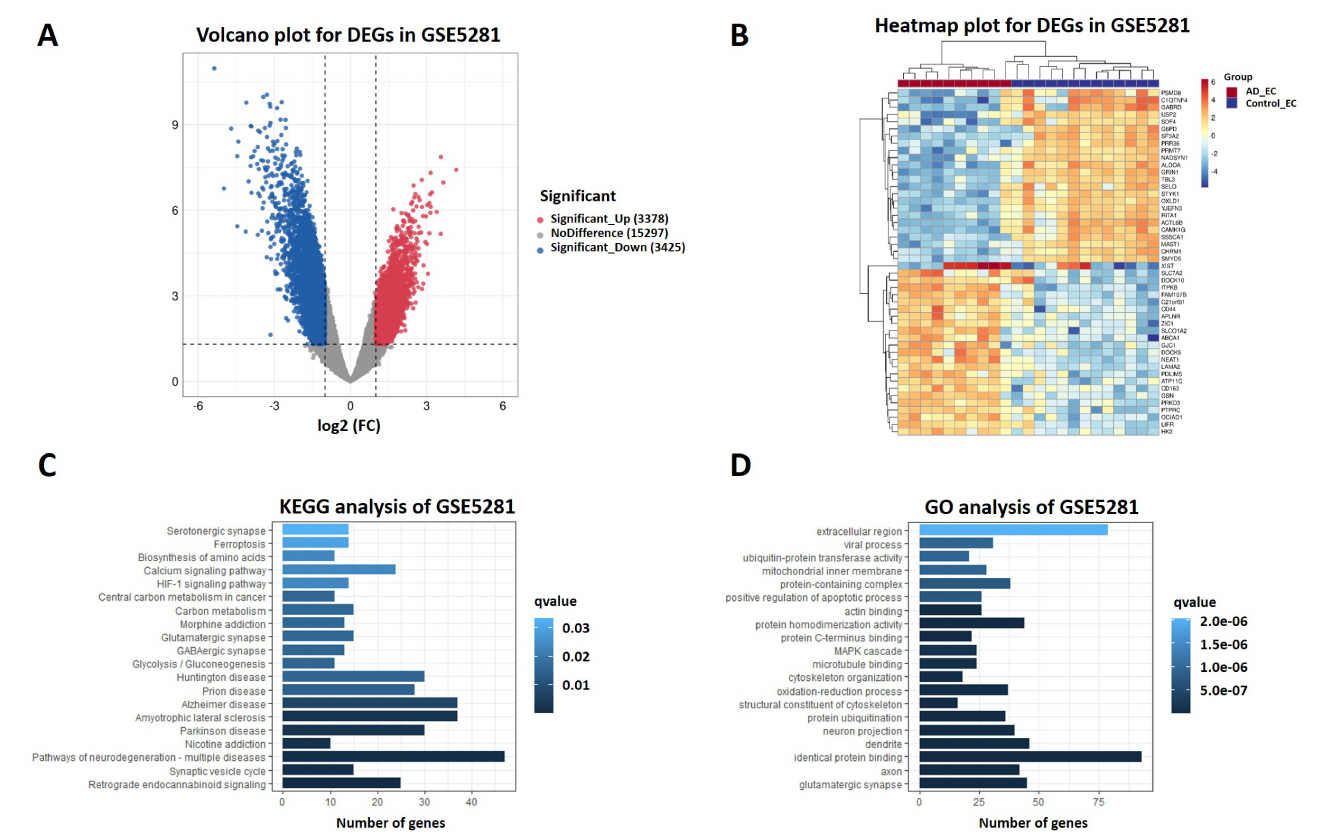
Figure 6. DEGs of AD from GSE5281 dataset. ( A ) Volcano plot of DEGs in GSE5281. Upregulated genes were colored in red and downregulated genes in blue. ( B ) Heatmap of top 25 upregulated and top 25 downregulated DEGs in GSE5281. ( C ) GO analysis of DEGs in GSE5281. ( D ) KEGG analysis of DEGs in GSE5281. GO: Gene Ontology. KEGG: Kyoto Encyclopedia of Genes and Genomes. DEGs: differentially expressed genes. FC: fold change. EC: entorhinal